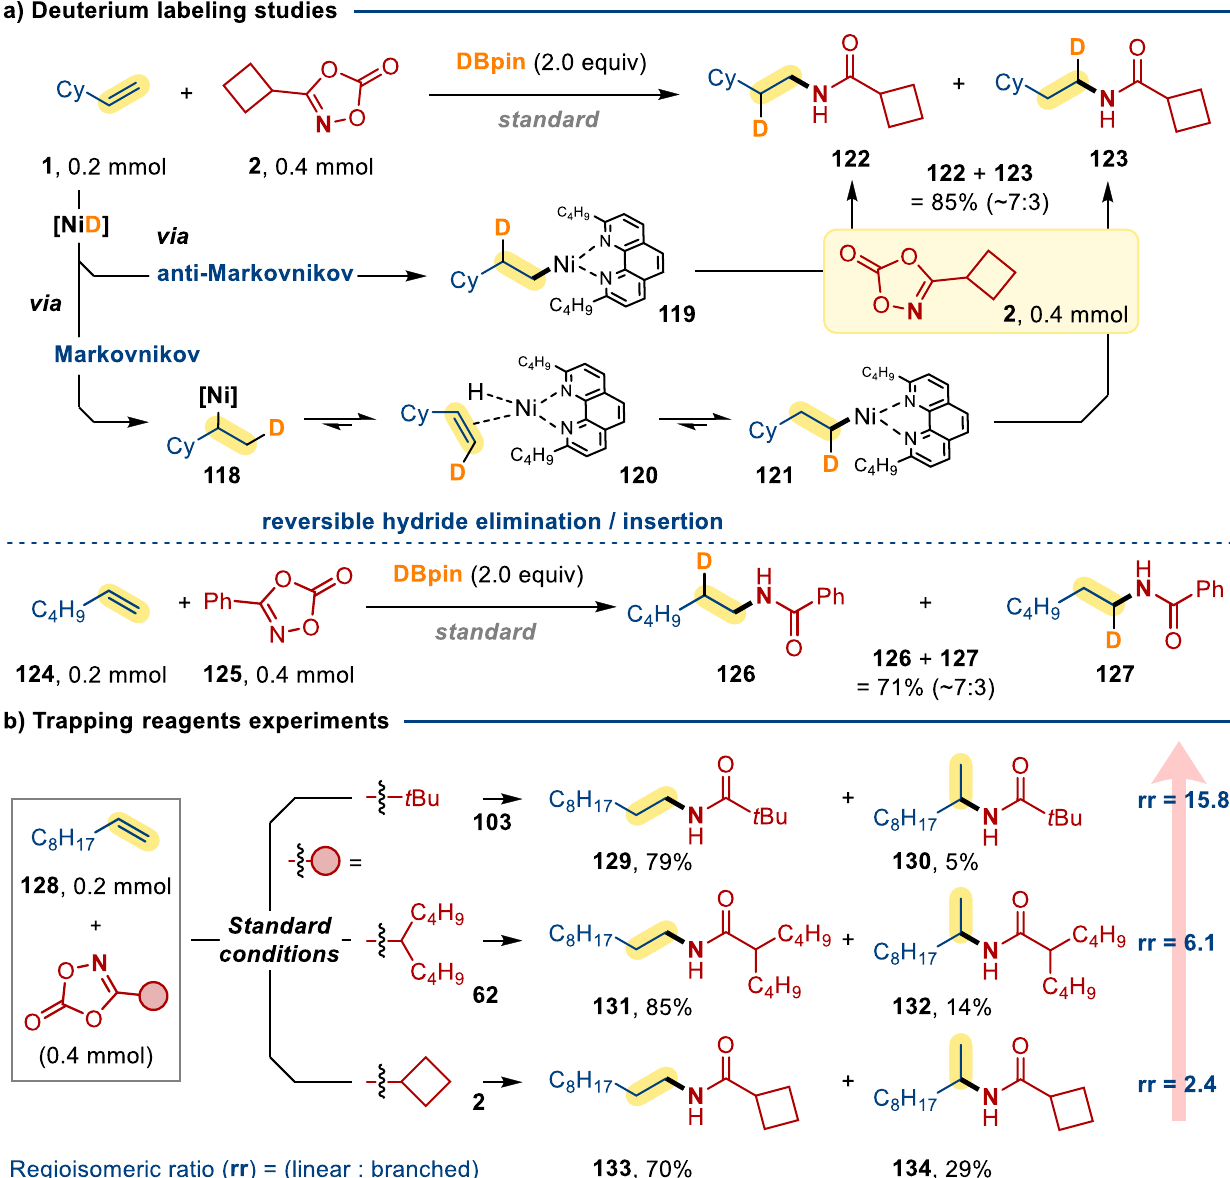
Fig. 7 Mechanistic study — deuterium labeling studies and steric effect on regiosiomeric ratio. a Deuterium labeling studies. b Trapping reagents experiments. Standard conditions: [Ni(ClO 4 ) 2 ] ∙ 6H 2 O (10 mol %), L4 (12 mol %), HBpin/DBpin (2.0 equiv), THF + DMA (1.8 + 0.2 ml), in N 2 at room temperature for 12 h. All the yields presented are NMR